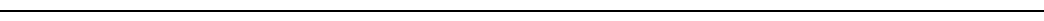
Fig. 6 Allosteric PYK-based molecular OR logic gate synergistically regulates energy and carbon metabolism in mycobacteria. Histograms of metabolic changes at S4, S10, S22 and R6 against Log in nutrient-starvation model; abundance data were normalised to protein concentration and represent mean ± SD, n = 4; signi fi cance is indicated as * p < 0.05, ** p < 0.01, *** p < 0.001 by one-way ANOVA with Dunnett post test versus Log. a Schematic illustration of glycolysis pathway and metabolic changes in M. bovis BCG during nutrient starvation. The allosteric activator of Mtb PYK, glucose-6-P (G6P), is shown in magenta, while PYK substrates (ADP and PEP) and products (ATP and pyruvate) are coloured in red. b A schematic representation of the molecular OR gate. The metabolite G6P (magenta square) and the low-energy-state signal AMP (purple rectangle) are two molecular inputs into the gate which is composed of inactive Mtb PYK and its substrates (red trapezoid). The enzyme Mtb PYK is activated (output) by the binding of either molecule input or both molecules cooperatively at certain concentrations. The sensitivity to one input molecule is increased as the concentration of the other input molecule increases. The Mtb PYK tetramers in inactive T-state, AMP-activated R-state, G6P-activated R-state and AMP/G6P-activated R-state are all shown in schematic representations. Domains are highlighted in one subunit: A domain in green, B domain in grey, C domain in blue. Secondary structures and residues, that undergoes signi fi cant movements from T-state to activated R-state, are shown as cartons and sticks. AMP loops are indicated as red lines. A logic gate table is also shown on top. High = high concentration; Low = low concentration. c A three-dimensional (3D) graph shows the relation of activator concentrations and Mtb PYK activity in vitro. ‘ % V max ’ is expressed as the percentage of maximum velocity in the presence of saturating activators. The activities were measured in vitro using puri fi ed Mtb PYK in the presence of 4 mM ADP and 0.2 mM PEP. d Thermal shift assay results for fi ve Mtb PYK complexes. All data are mean ± SEM for two independent experiments done in